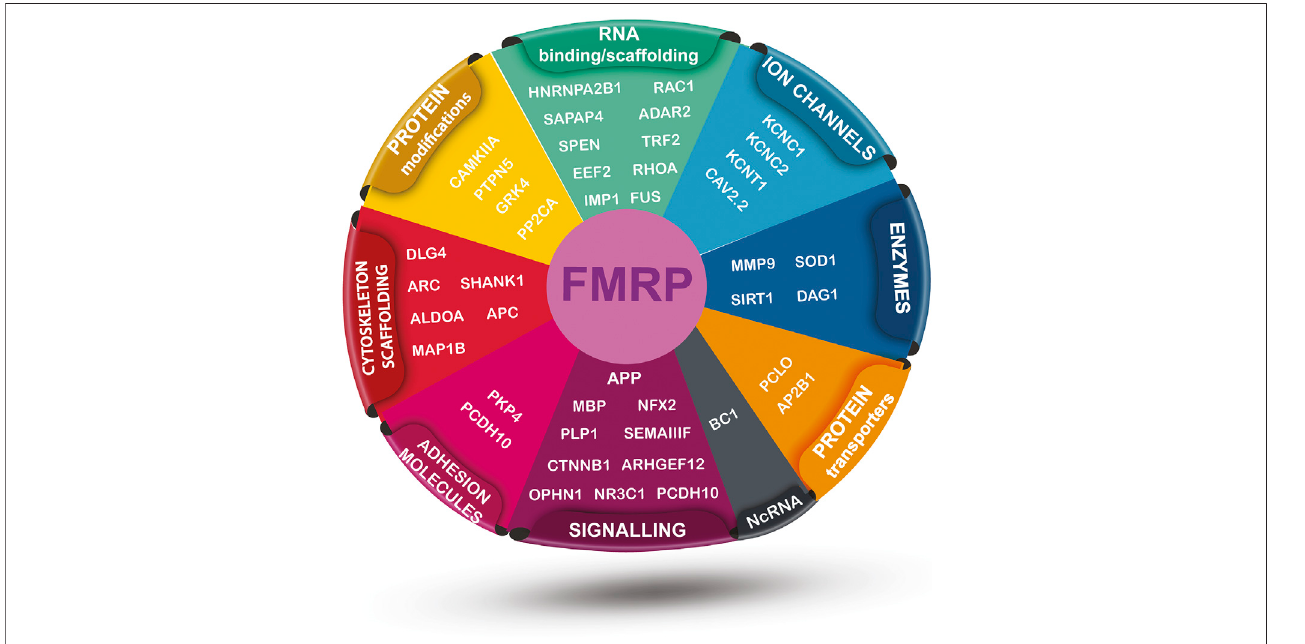
FIGURE1| FMRP-interacting targets mRNAssorted bytheir generalfunction. Theillustration includes vectors modi fi edfrom “ Vecteezy ” and itisdistributed under the Creative Commons Attribution 4.0 license (CC BY 4.0).